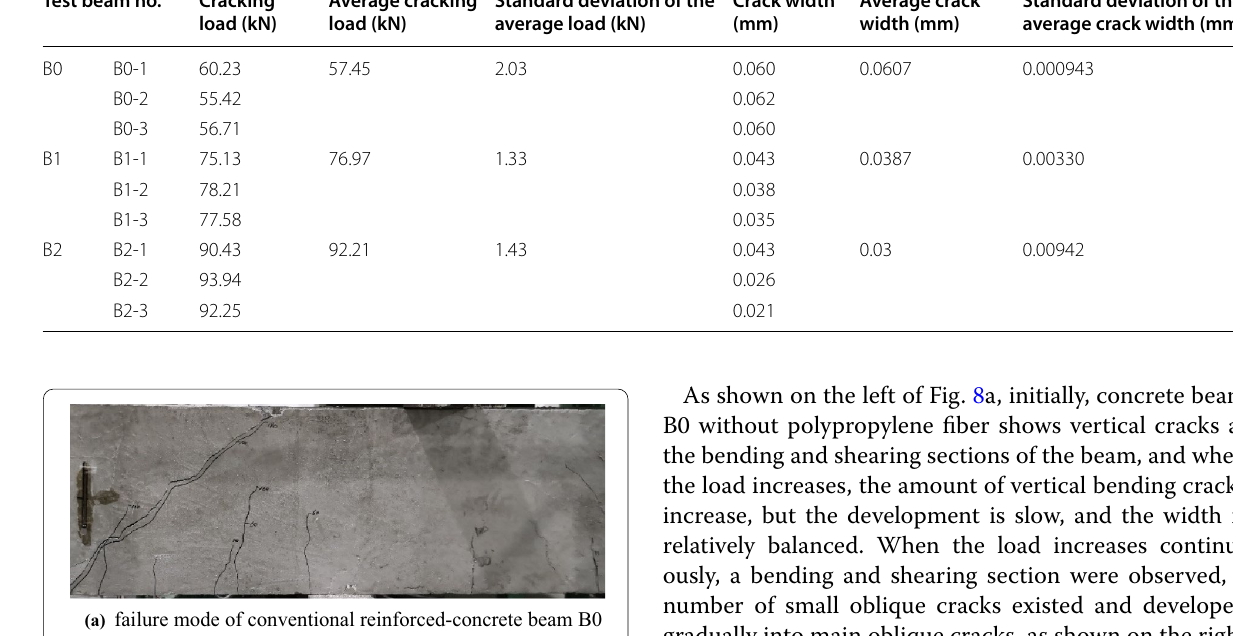
Table 5 Cracking load and crack width of test beam. Test beam no.